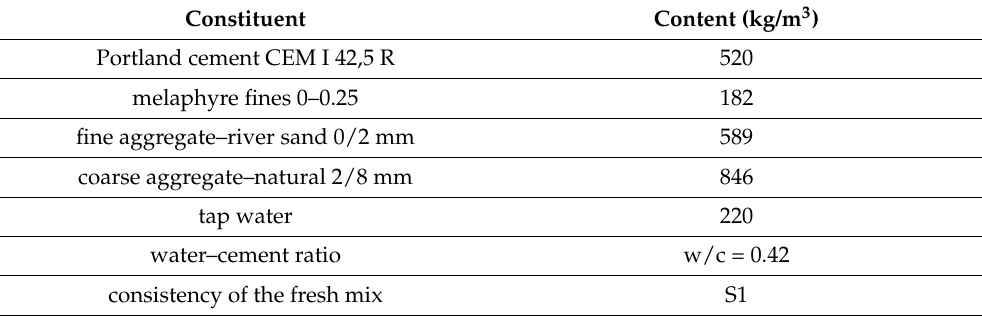
Table 1. Composition of tested